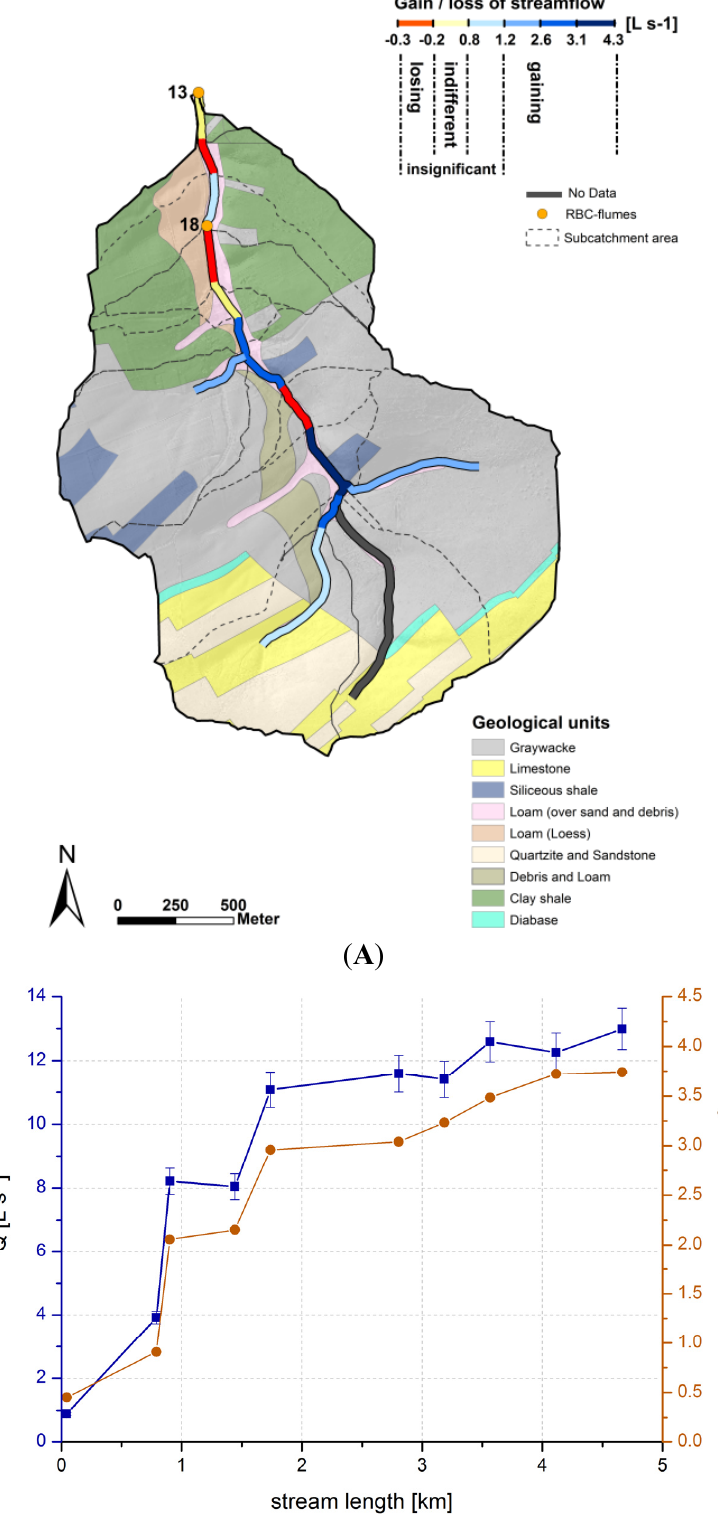
Figure 7. ( A ) Geological map including classification of the stream sections in gaining/losing reaches (L·s − 1 ); and ( B ) relationship between stream length (km), discharge Q (L·s − 1 ) ±5% error, and subcatchment area (km 2 ). The stream length is depicted from the headwater to the outlet from left to right. Note that tributaries are not included in Figure